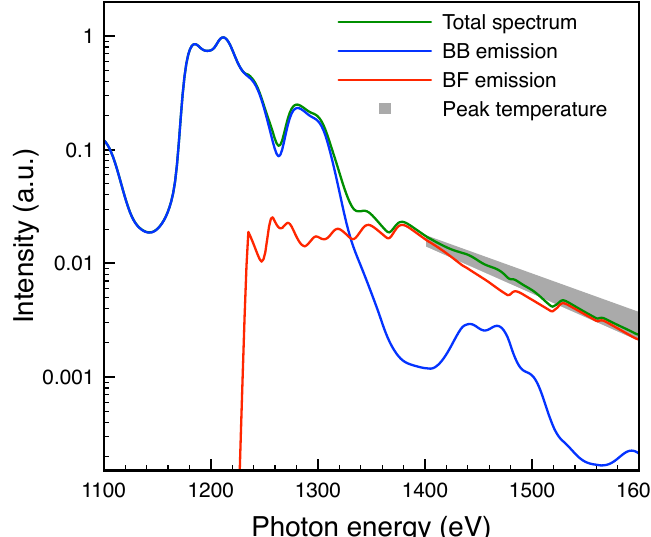
Figure 2. Bound-bound and bound-free components of the time-and-space integrated spectrum from the Cretin simulations corresponding to an XFEL photon energy of 1400eV. For energies of the emitted photon above 1400eV, the spectral emission is dominated by bound-free transitions. The gray area shows the slope of the bound-free emission at the peak temperature ± 10%, which agrees with that of the integrated